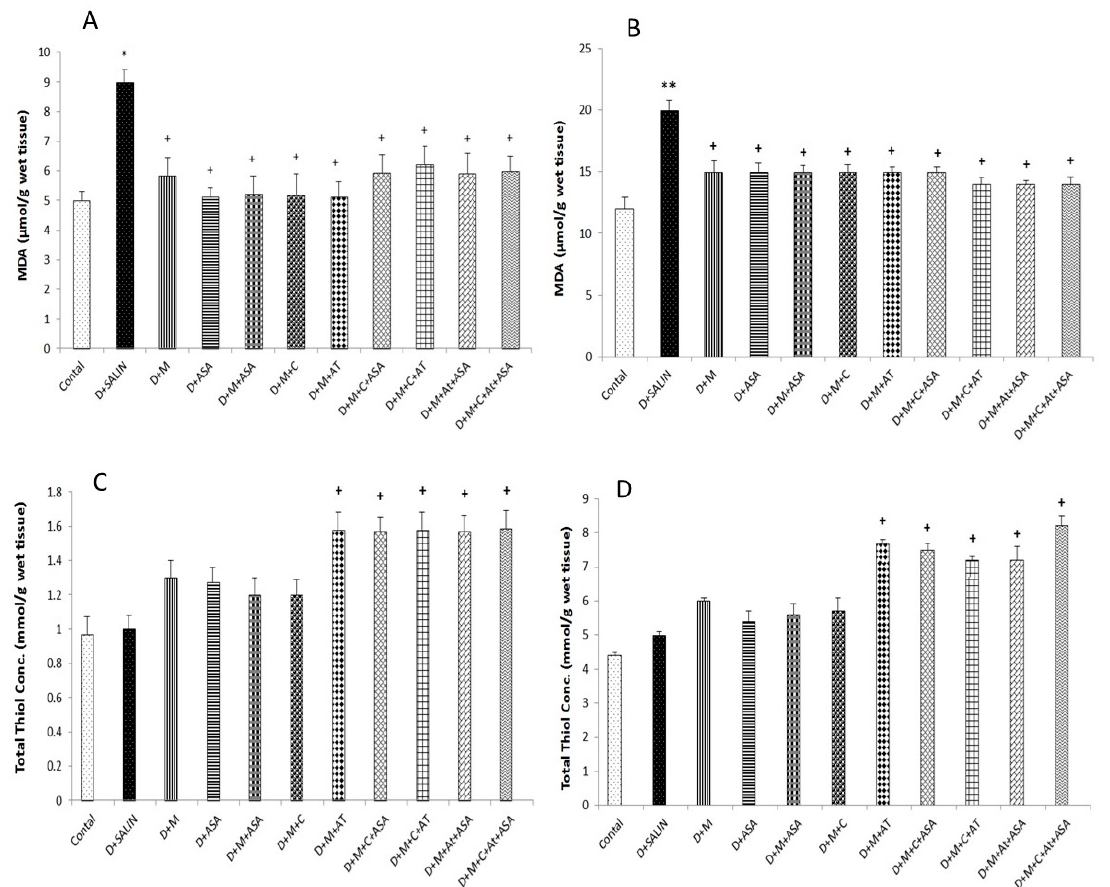
Figure 3. Malondialdehyde (MDA) and total thiol concentrations in the cortex ( A , C ) and hippocampus ( B , D ) tissues. Data are shown as mean ± SEM. * p < 0.05 and ** p < 0.01 compared to control. + p < 0.05 compared to non-treated diabetic group. D, diabetic; M, metformin; ASA; aspirin; AT, atorvastatin; and C, captopril.